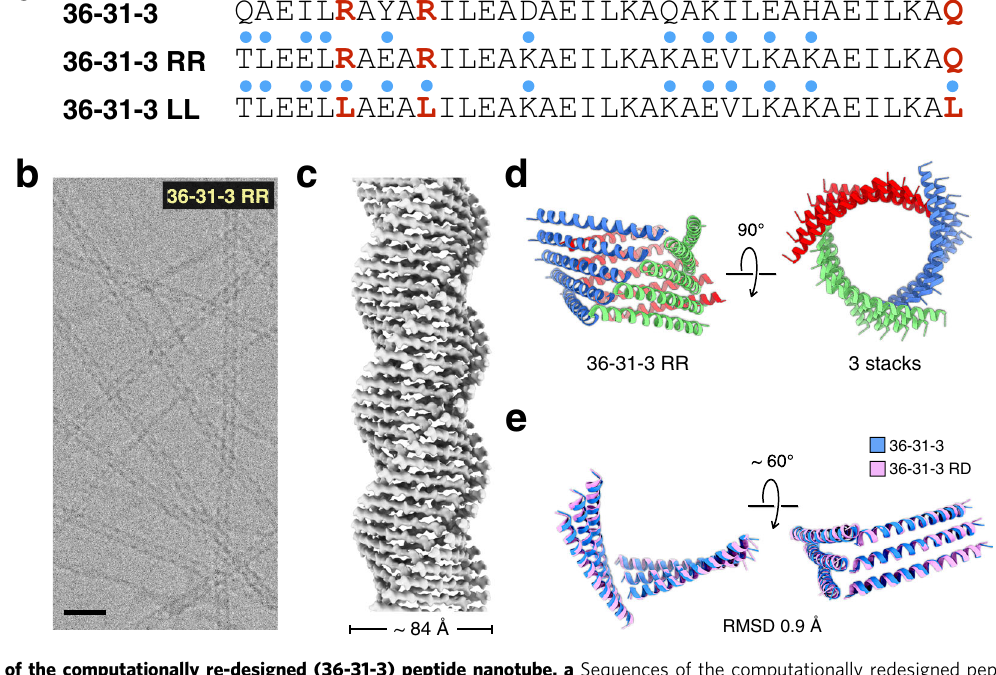
Fig. 7 Cryo-EM of the computationally re-designed (36-31-3) peptide nanotube. a Sequences of the computationally redesigned peptides 36-31-3_RR and 36-31-3_LL in comparison to the parent sequence. Residues changed from original the 36-31-3 sequences are highlighted with blue dots on top. b Representative cryo-EM image of 36-31-3_RR peptide fi laments out of a total number of 166 images recorded. Scale bar is 20 nm. c Cryo-EM reconstruction of the 36-31-3_RR fi laments. d Side view and top view of the atomic model. e Alignment of two adjacent cross- α stacks between 36-31-3 (blue) and 36-31-3_RR